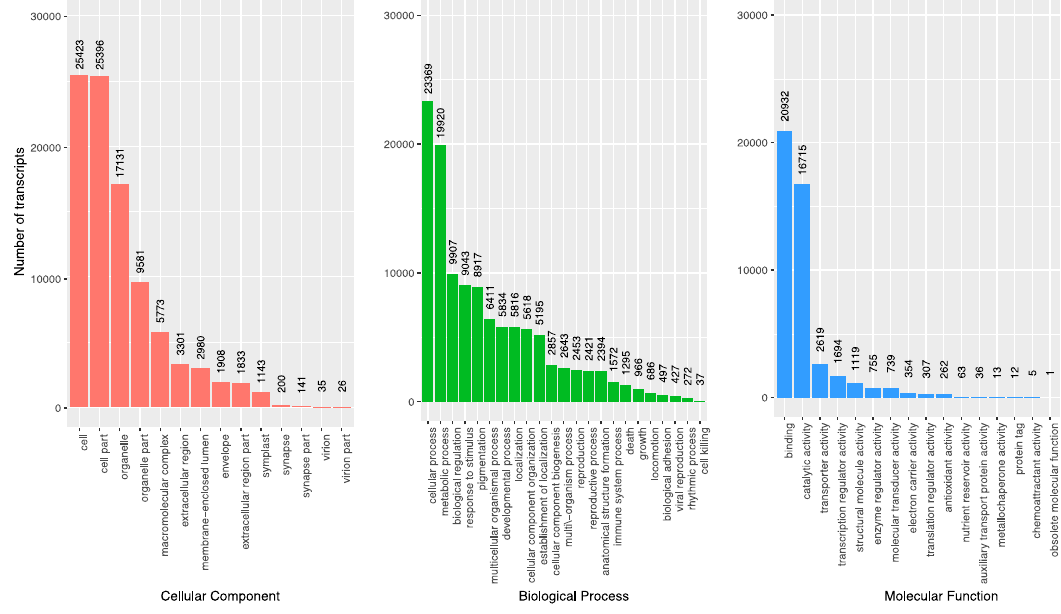
Figure 5. Distribution of top GO term categories. Distribution of most abundant GO terms for each of three major GO term hierarchies from GO terms assigned to T. radicans transcripts.